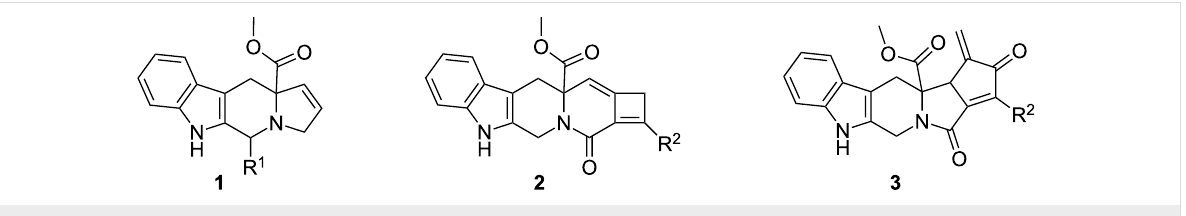
Figure 1: Tetrahydro- β -carboline containing scaffolds 1 – 3